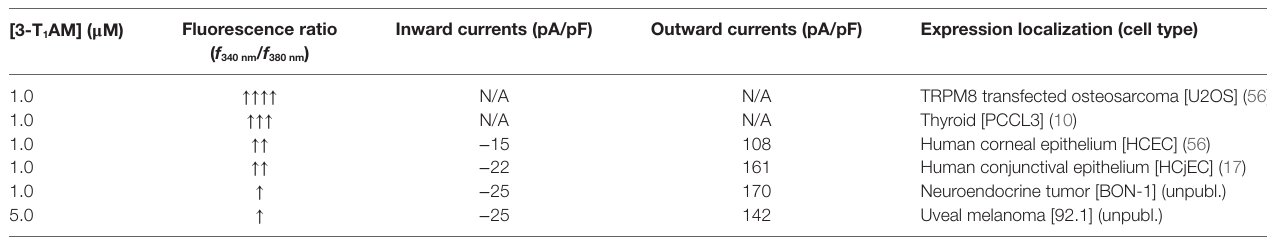
TABLe 1 | 3-T 1 AM effects in different cell